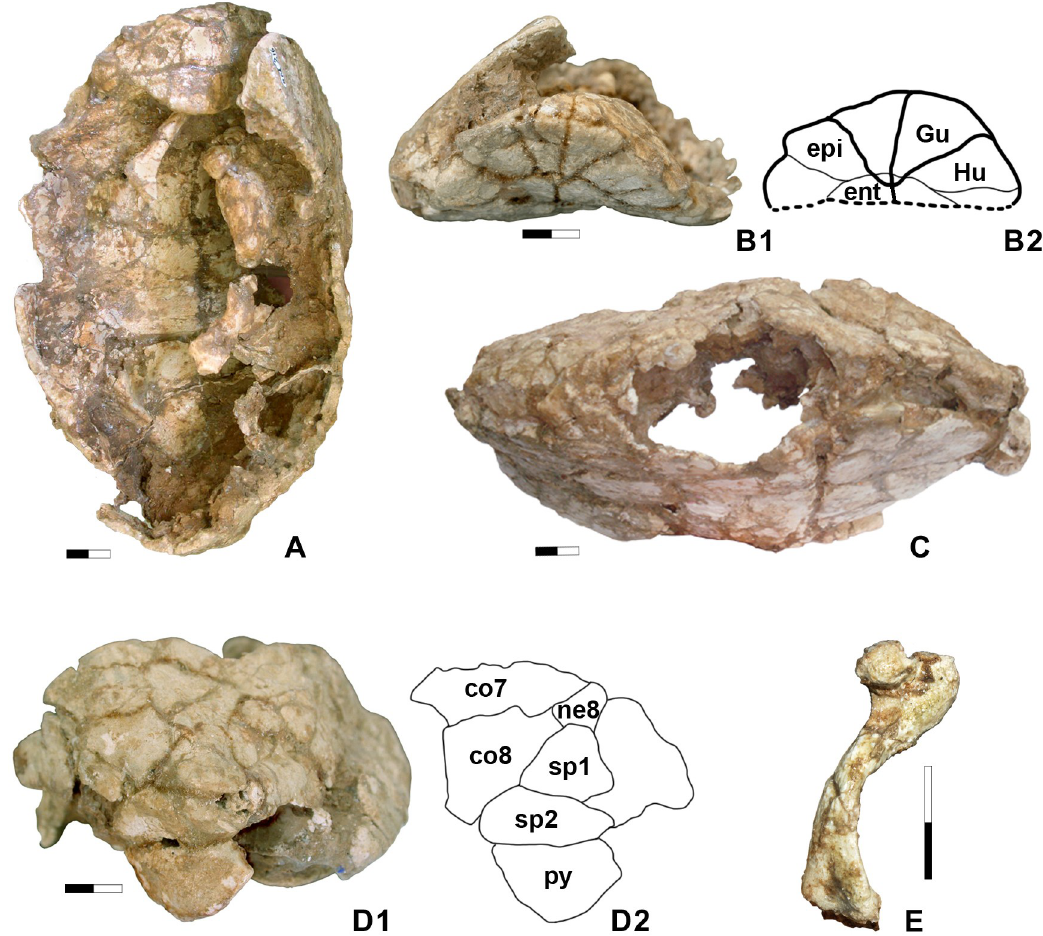
Right lateral view of the carapace. D1. Posterior shell border with suprapygal-pygal configuration. D2. Interpretative drawing. E. Left humerus in lateral view. Scale: 2